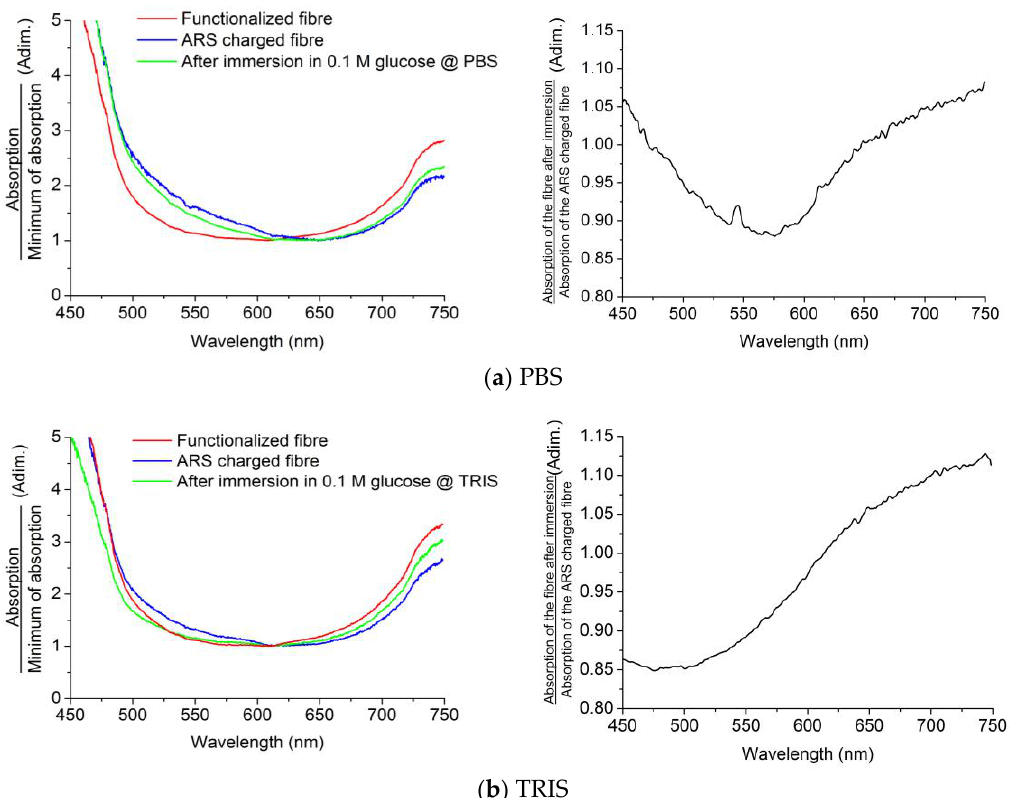
Figure 10. Normalized absorption curves of the probe before and after 10 min of immersion in 0.1 M glucose solution in PBS ( a ) and TRIS ( b ) ( left ); division of ARS-charged absorption and post-immersion absorption curves ( right ).